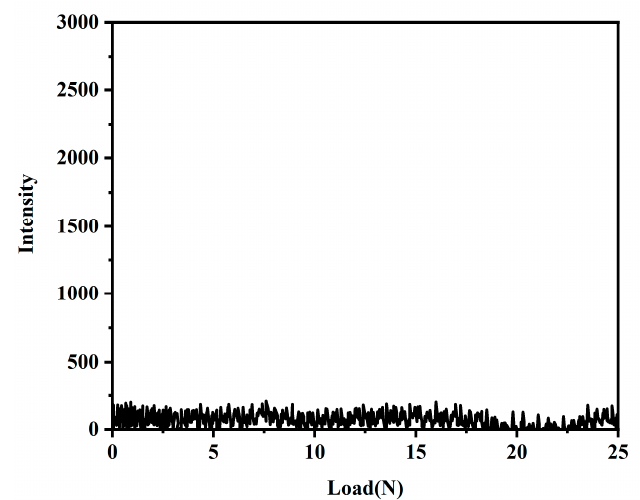
Figure 9. Acoustic emission signals of the PFTS-modi fi ed 0.5 g ZrO 2 -SiO 2 sample (load 25 N, loading time 60 s).